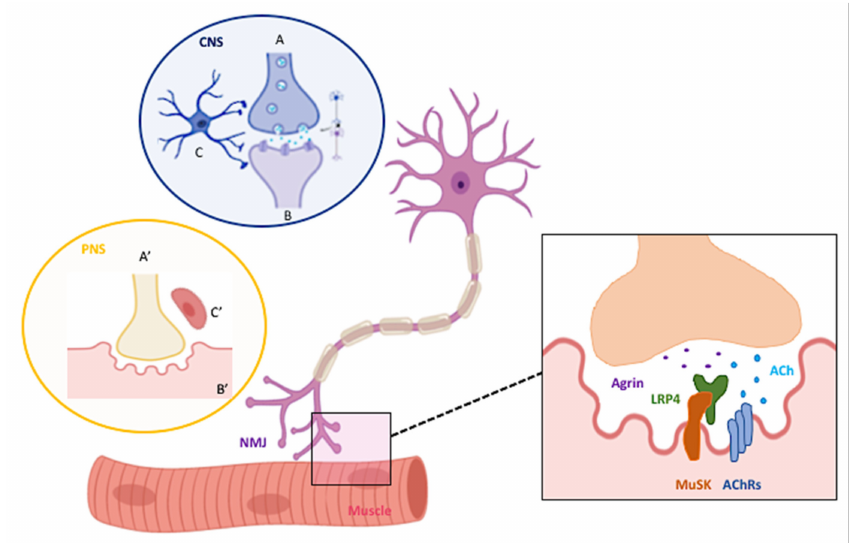
Figure 1. The central vs. the peripheral tripartite synapse. The NMJ is at the crossroad between the NS and the muscle, representing their cross-talk point. Central and peripheral synapses share a similar morphological feature: the tripartite synapse. Indeed, in the CNS the tripartite synapse is composed by a presynaptic axon ( A ), a postsynaptic dendrite ( B ) and by astrocytes ( C ). In the PNS, there is a comparable structure and the tripartite communication is between the axon terminal of the MN ( A (cid:48) ), the muscle fiber ( B (cid:48) ) and the terminal Schwann cells ( C (cid:48) ). The macromolecules involved at the nerve–muscle interplay are represented in the zoomed section. Created with BioRender